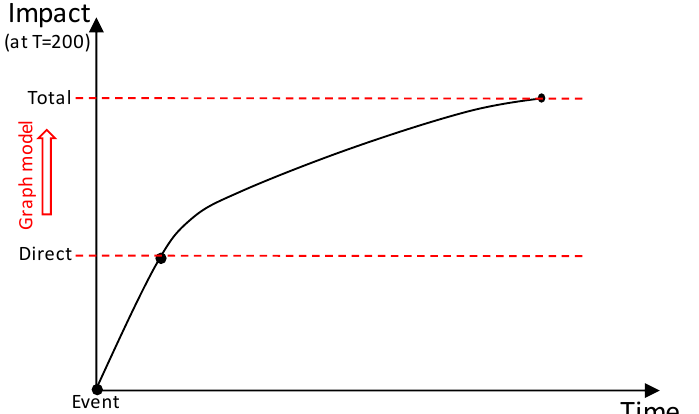
Figure 1. Conceptual propagation of the direct and indirect impacts in a system under probability scenario event of T = 200.